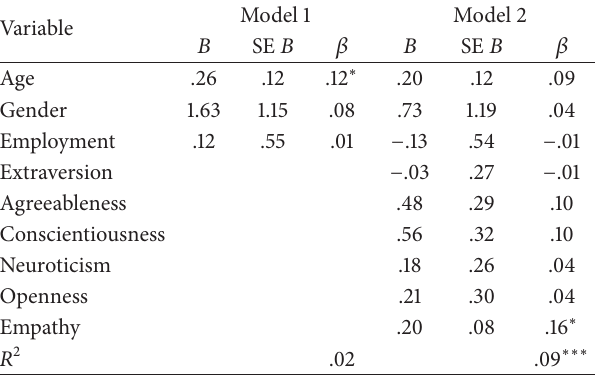
Table 6: Hierarchical multiple regression: association between demographics, personality traits, empathy, and willingness to pro- vide nursing